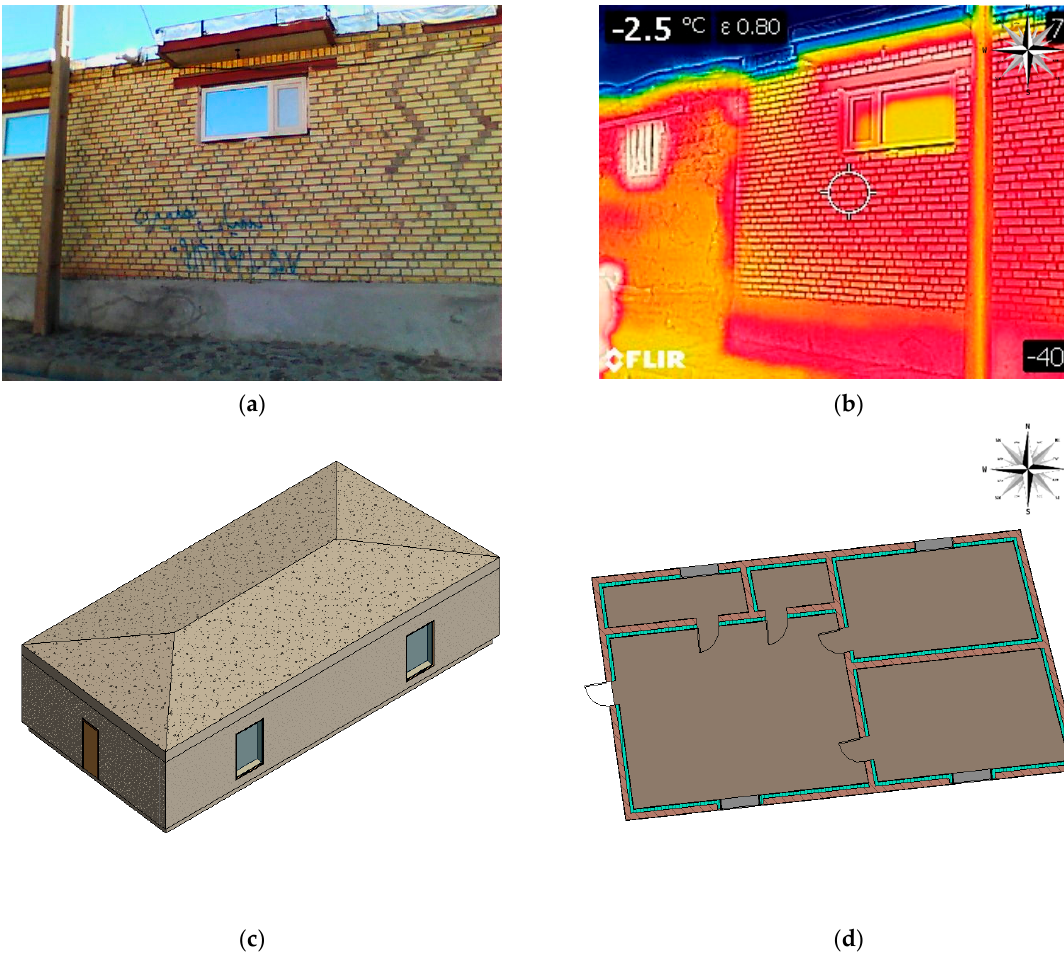
Figure 6. ( a ) Sample of old building of the village; ( b ) temperature contour of the building recorded at 30/10/2018, 8:00AM; ( c ) a sample model of building with the specified property in Table 1; and ( d ) top view of the sample building. Table 1. Sample building